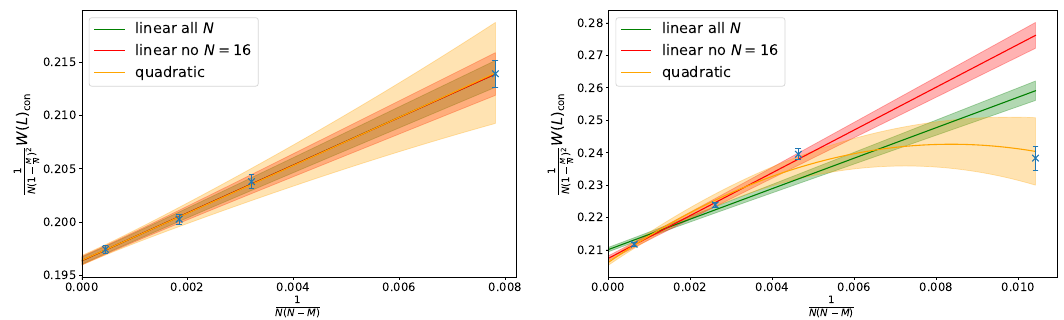
Figure 15. Performing the large N extrapolation for the confined subsector P = 0 . 2 (left) and P = 0 . 25 (right) for L = 1 . The continuum limit n t → ∞ has been taken. We try a linear fit of all points (green), a linear fit that ignores N = 16 (red), and a quadratic fit of all points (orange). The destabilising effect of the N = 16 (rightmost) point in the P = 0 . 25 linear extrapolation is obvious and can be attributed to the small value N − M = 6 .